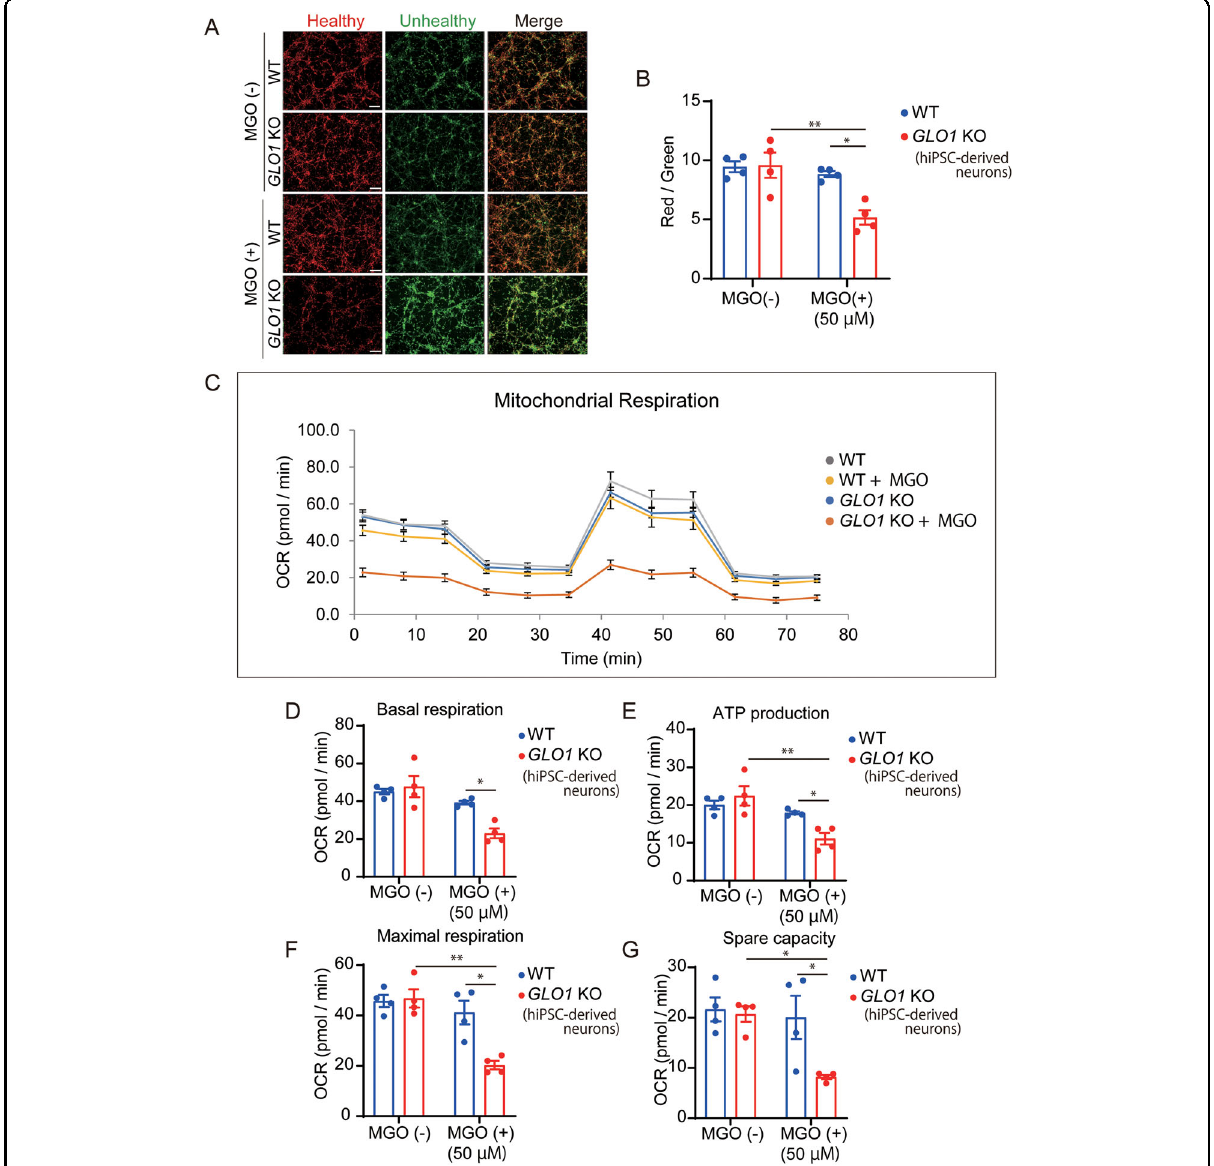
Fig. 4 Evaluation of mitochondrial function in WT and GLO1 KO neurons after treatment with MGO. A , B JC-1 staining of WT and GLO1 KO neurons after treatment with 50 µM MGO for 24 h. Scale bar: 100 µm ( A ). The ratio of red to green is an indicator of mitochondrial membrane potential ( B ). C Plot of oxygen consumption rate (OCR) in WT and GLO1 KO neurons using Seahorse extracellular fl ux analyzer after treatment with 50 µM MGO for 24 h. D − G Quanti fi cation of basal respiration ( D ), ATP production ( E ), maximal respiration ( F ), and spare capacity ( G ). GLO1 KO neurons showed signi fi cantly lower respiratory function after treatment with 50 µM MGO. Data represent mean ± SEM. * P < 0.05, ** P < 0.01; two-way ANOVA, followed by Tukey ’ s multiple comparison